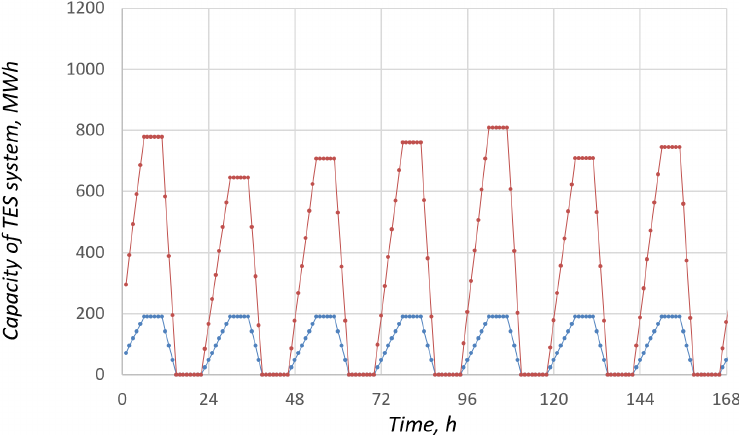
Figure 9. Capacity of TES system as a function of time for first week of reference year (blue—TES25 (200 MWh), and red—TES150 (1200 MWh)).